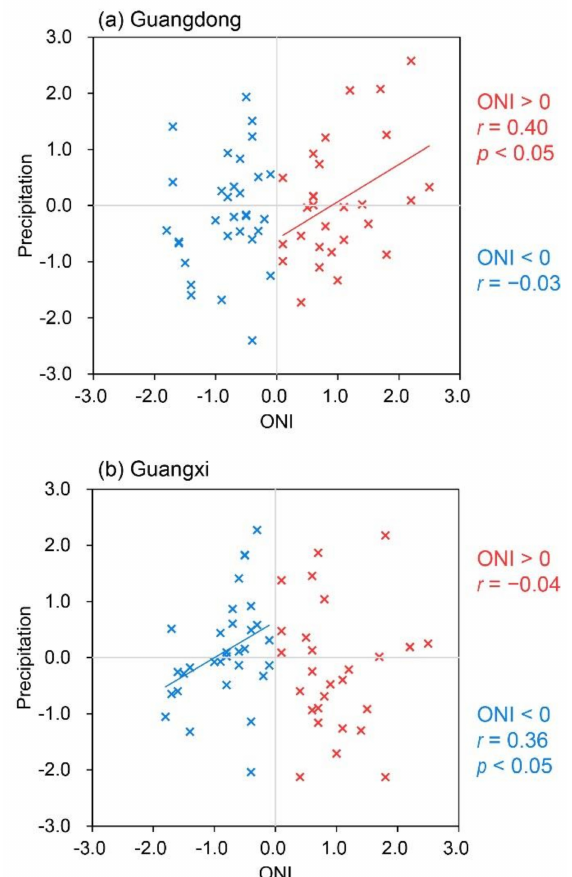
Figure 8. Relationships of spring precipitation anomalies over the ( a ) Guangdong province and ( b ) Guangxi province with the preceding winter ONI for the period of 1958–2019. The blue and red colors are for the years with ONI < 0 (31 years) and ONI > 0 (28 years), respectively. The r is the correlation coefficient between spring precipitation anomalies and the preceding winter